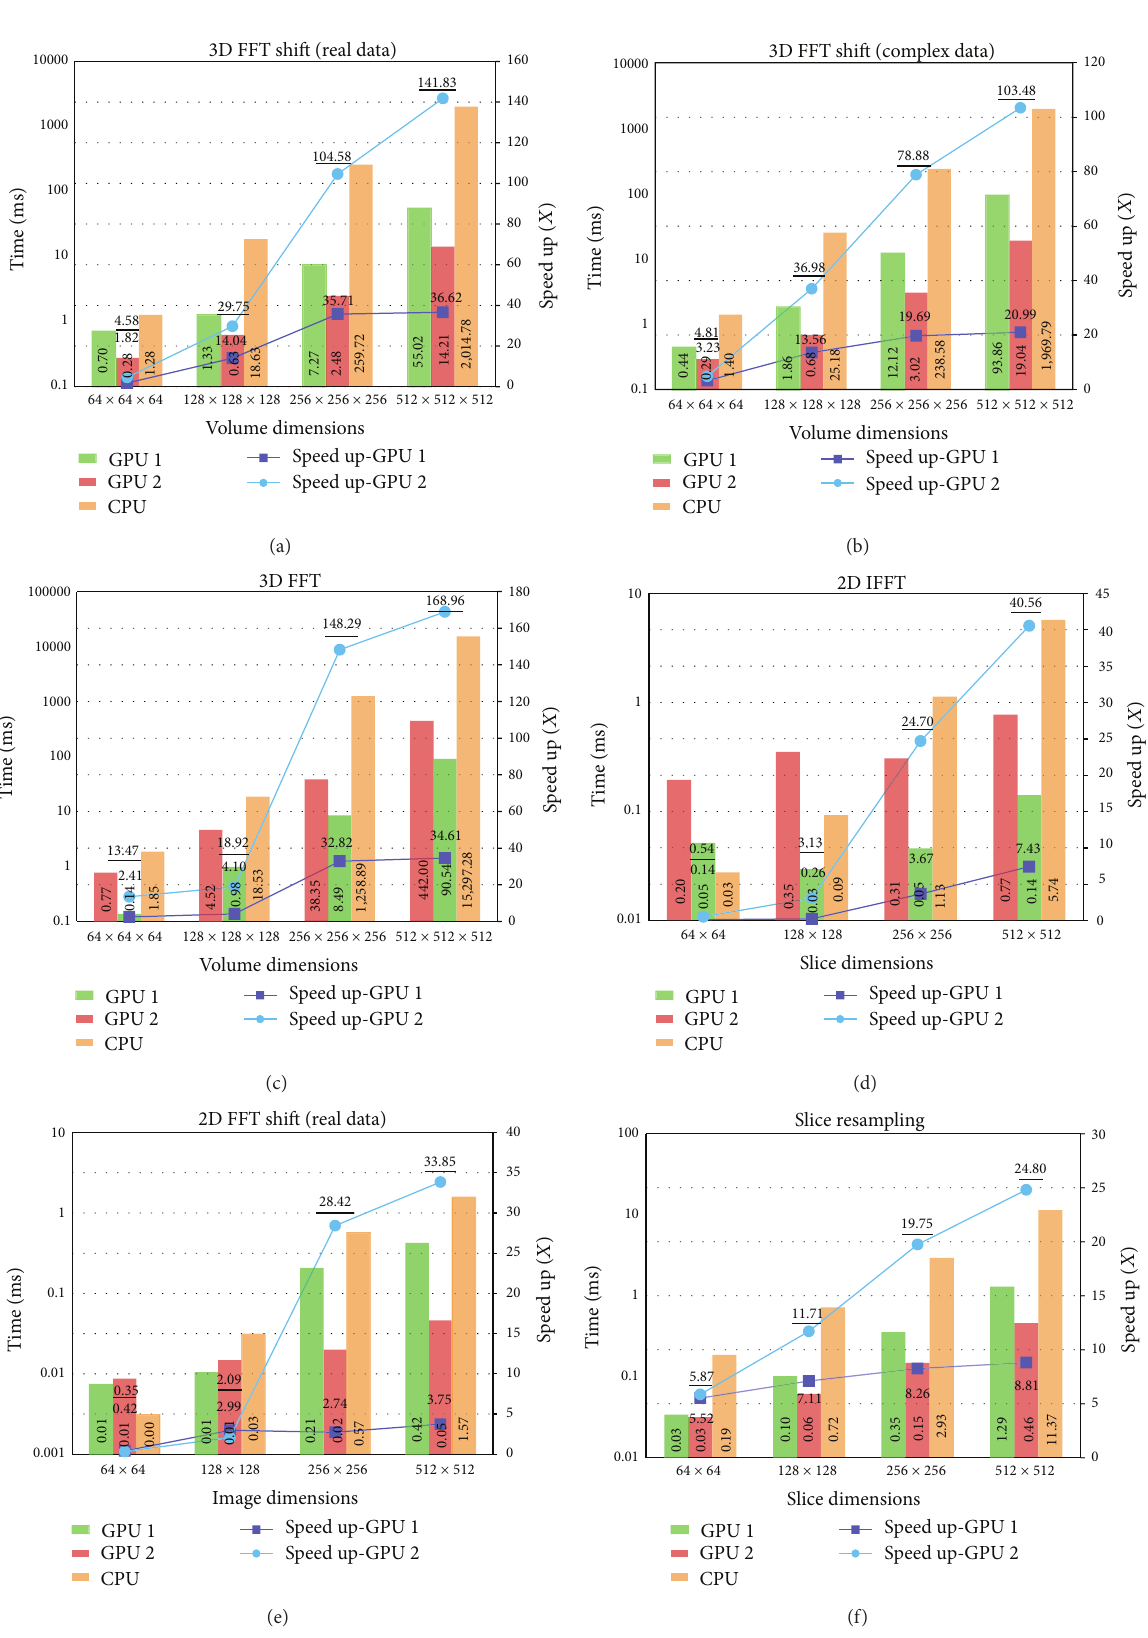
Figure 12: Benchmarking results of the different stages of the rendering pipeline executed on two different GPUs. GPU 1 is an NVIDIA GeForce GT 640, and GPU 2 is an NVIDIA QUADRO